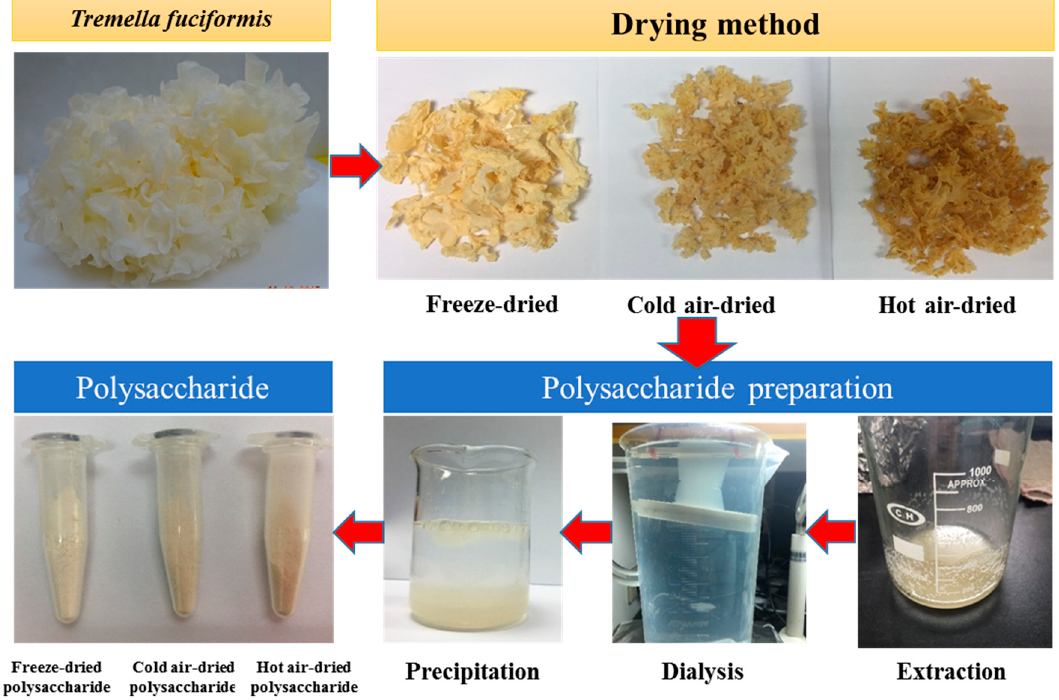
Figure 1. The flow diagram of the T. fuciformis sample and polysaccharide preparation. Table 2. Yield, molecular weight, and moisture content of T. fuciformis polysaccharides obtained by various drying